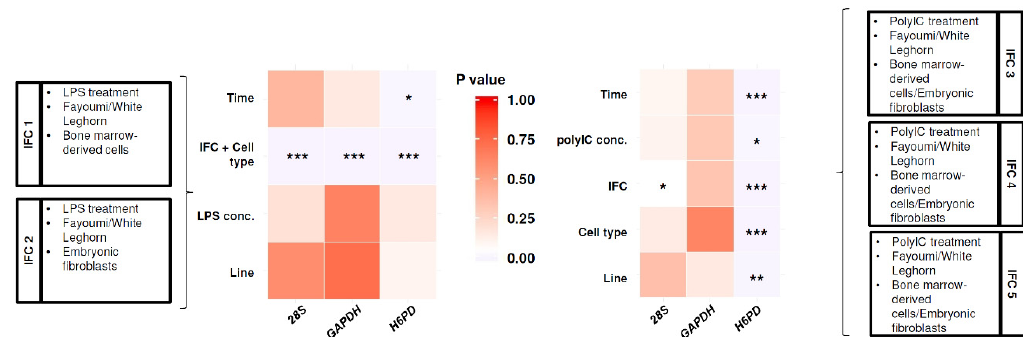
Figure 1. Statistical analysis for impact of experimental variables on Ct values of reference genes among Fluidigm 192.24 Integrated Fluidic Circuits (IFCs). p -values for each experimental variable and loaded sample information for each IFC are shown. *, p < 0.05; **, p < 0.01; ***, p < 0.001.